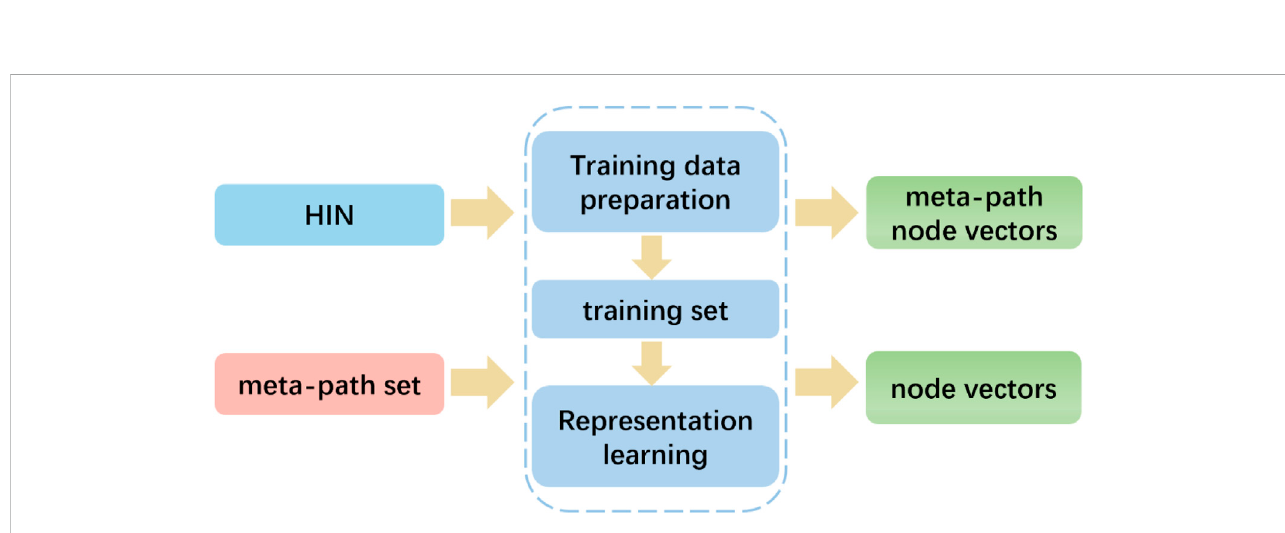
FIGURE 6 HIN2Vec fl owchart: Extraction of node eigenvectors using HINs and